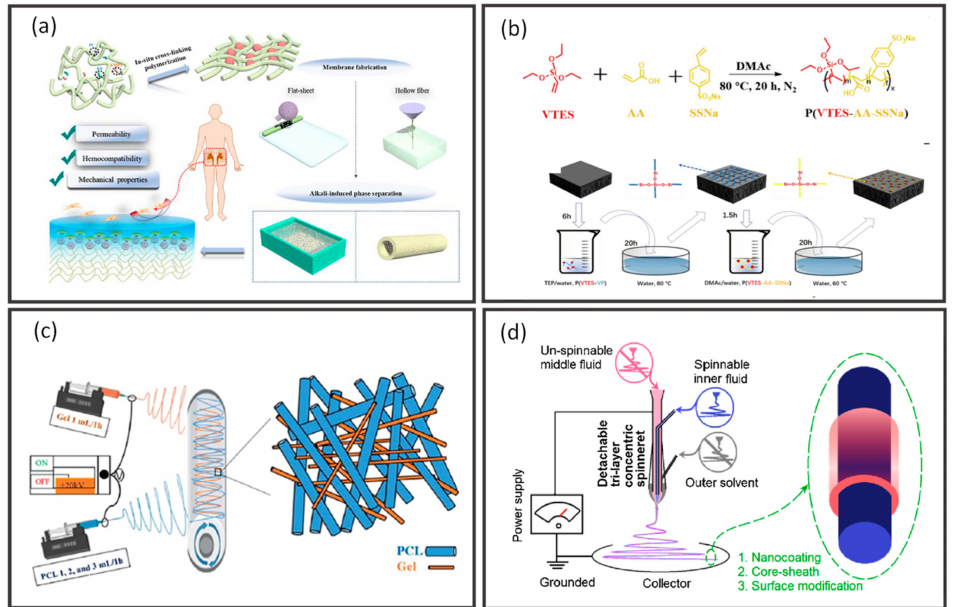
Figure 18. ( a ) Demonstration of NaOH-induced phase separation for the heparin-mimicking mod- ified hollow fiber membrane. Reprinted/adapted with permission from Ref. [632].